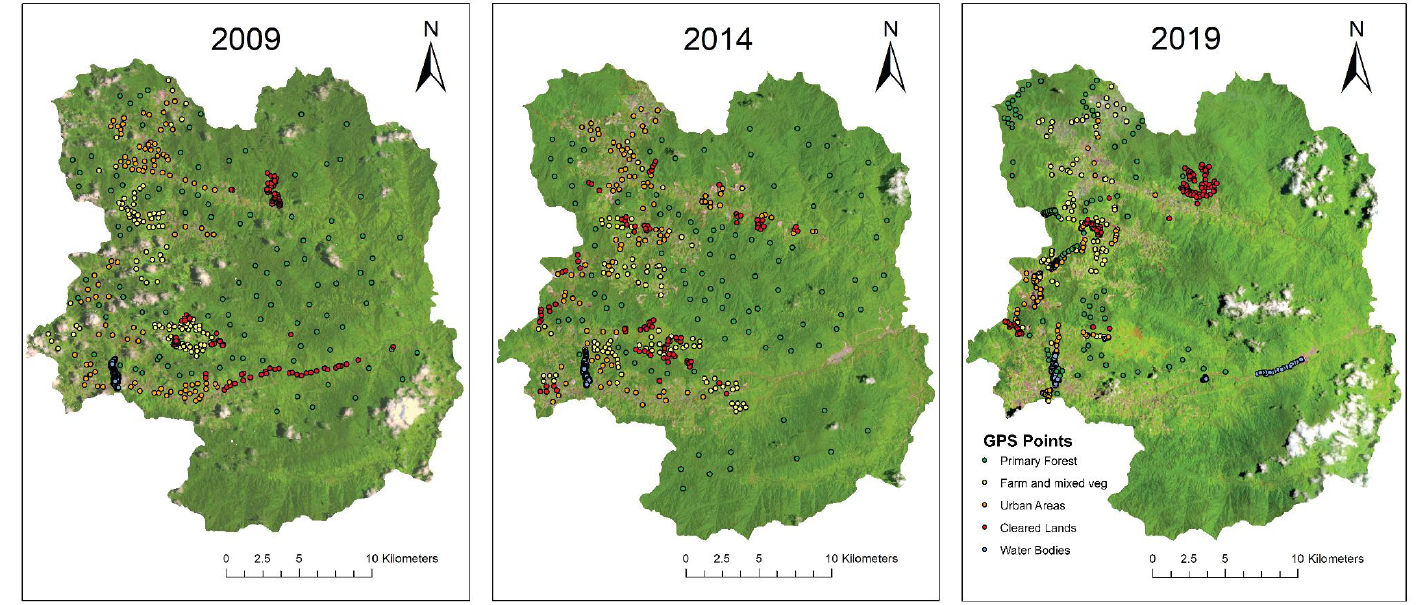
Figure 7. Test accuracy using Google Maps for years 2009 and 2014. GPS points used for year 2019.